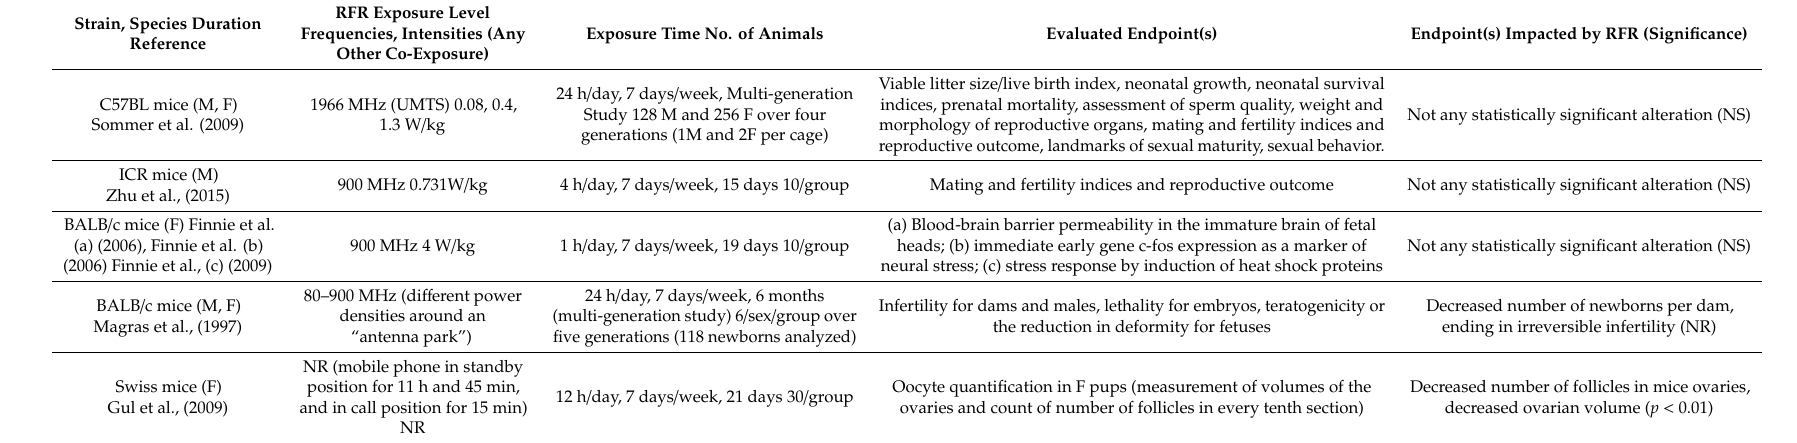
Table 8. Female reproductive studies and other reproductive / developmental endpoints in mice exposed to